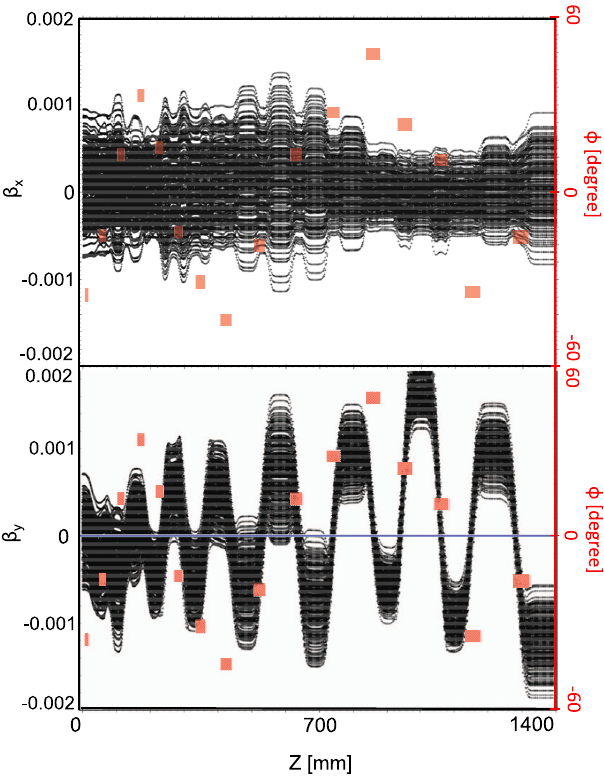
FIG. 6. Beam velocity distribution as a function of distance along the IH structure (black) and synchronous phase in each position (red). β (top) and β (bottom) along beam x y